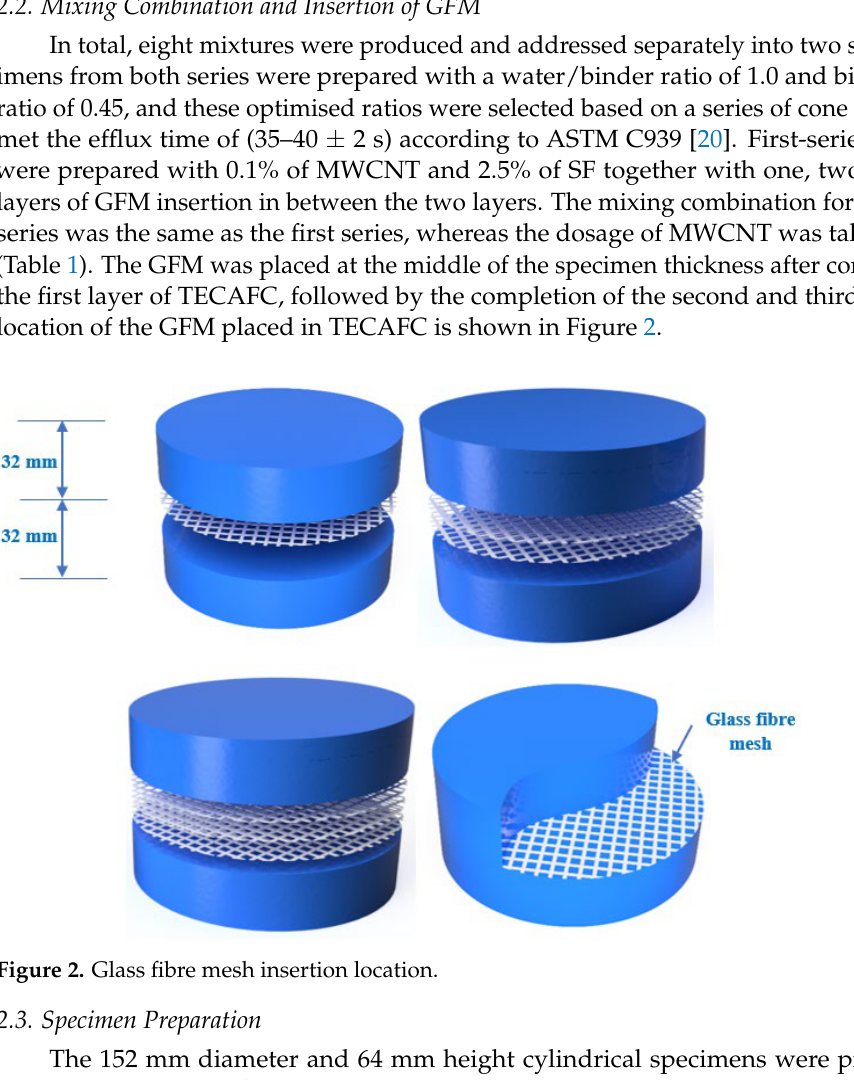
Figure 2. Glass fibre mesh insertion